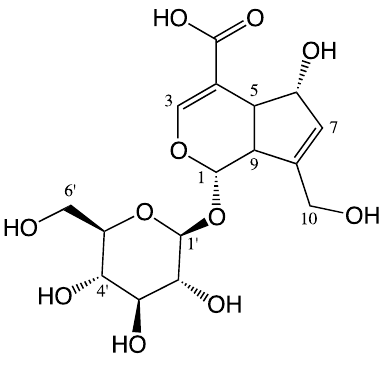
Figure 1. Chemical structure of scandoside (SCA).